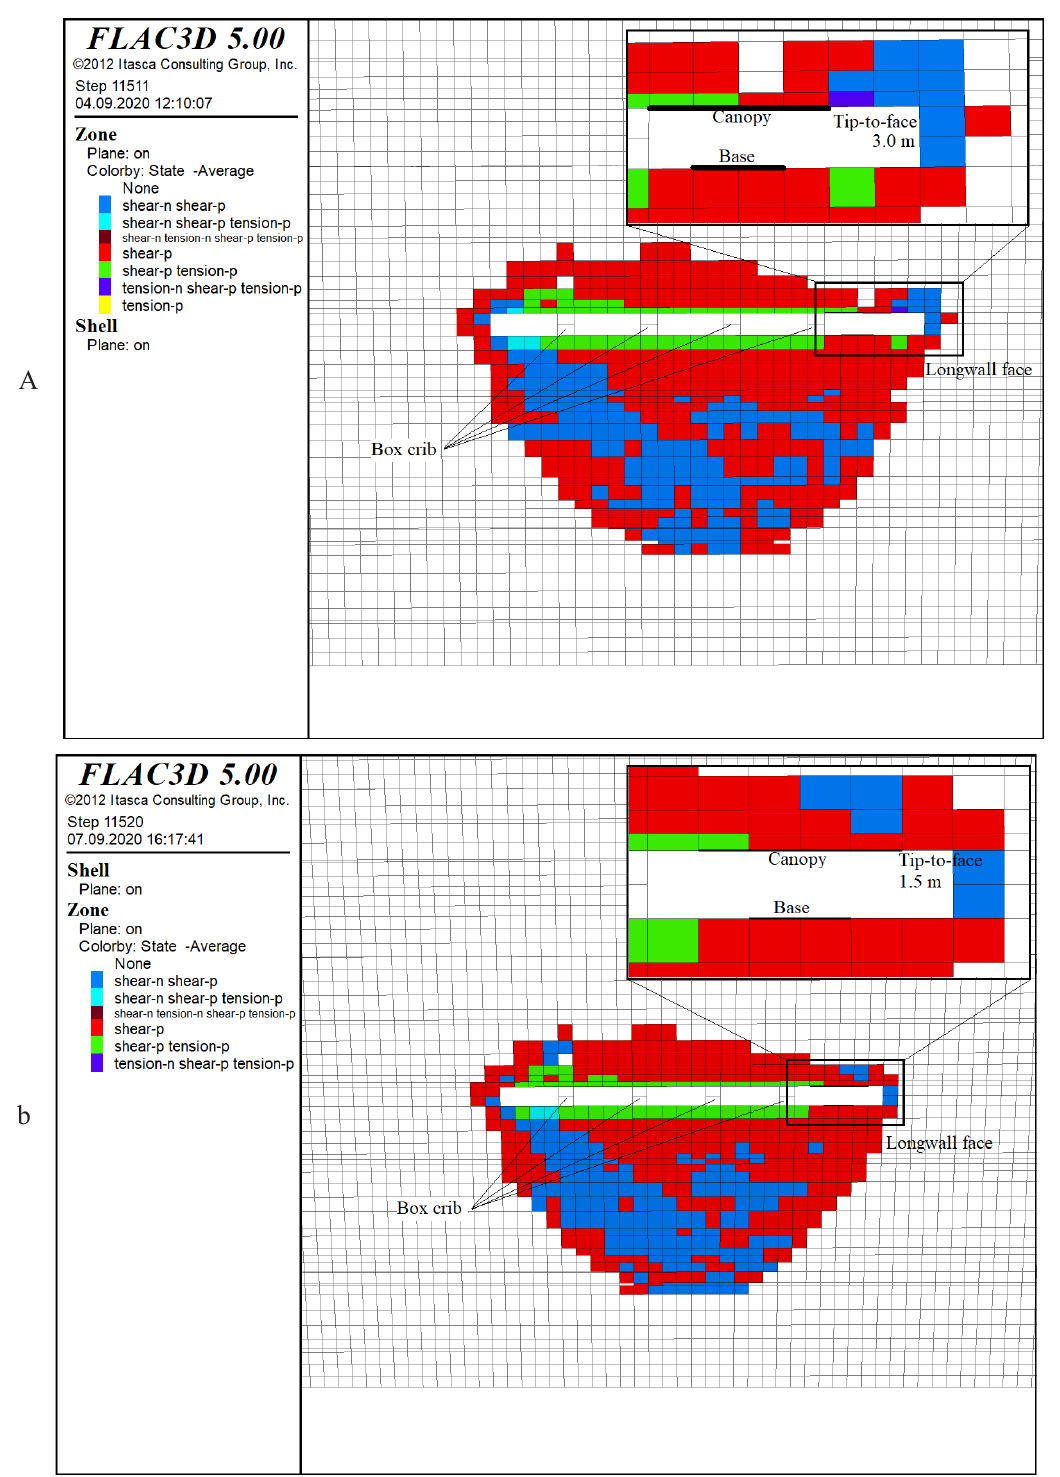
Figure 18: Plasticity around the longwall face with a) tip-to-face distance of 3 m, b) tip-to-face distance of 1.5